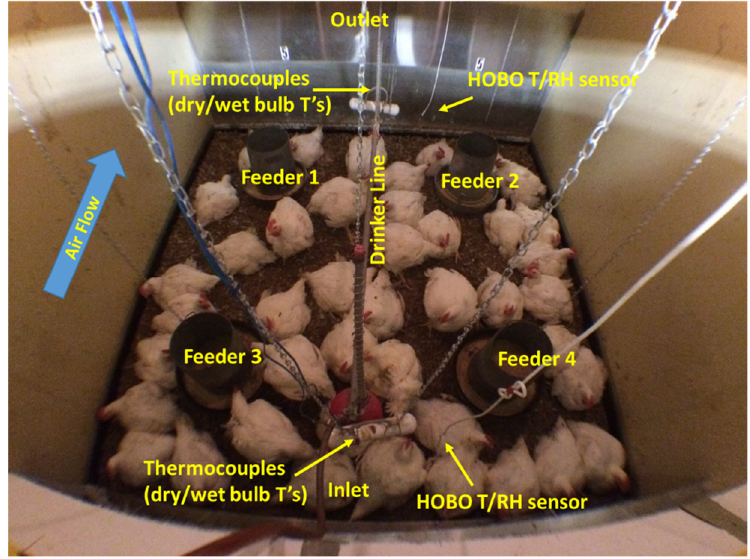
Figure 1. Broilers, feeders, drinker-line, and sensors in the core chambers.